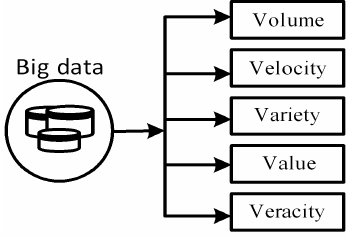
Fig. 1 General concept of